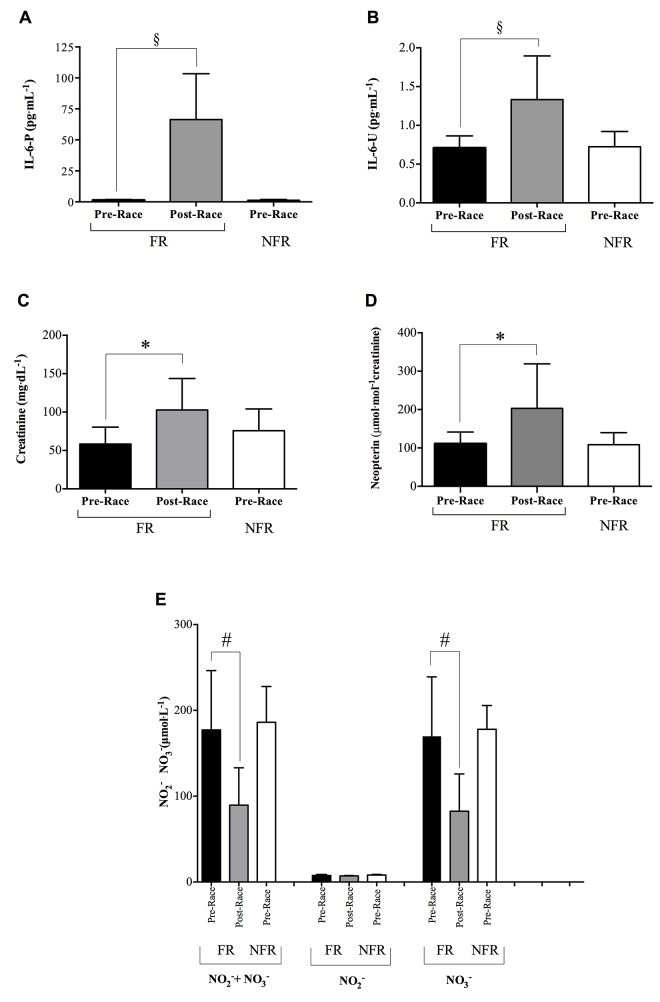
Effect of MUM on the inflammatory state.Histograms of: A) IL-6-P (pg.mL-1), B) IL-6-U (pg.mL-1), C) Creatinine (mg.dL-1), D) Neopterin (μmol.mol-1 creatinine) levels, and E) NO metabolites: Nitrite (NO2
-) and Nitrate (NO3) concentrations, in the FR (full bars) and NFR (empty bars) groups. Results are expressed as mean ± SD. Statistically significant differences symbols: P<0.05 (*); P<0.01 (#), P<0.001 (§) compared to Pre-Race.